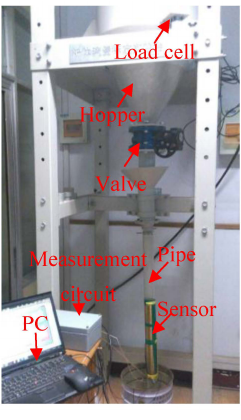
Figure 14. Gravity-fed rig.